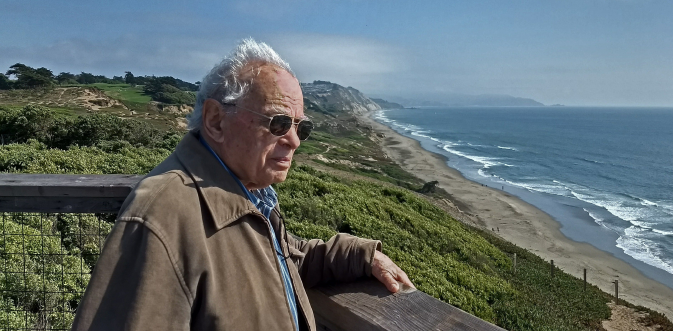
Figure 4. August 2017, San Francisco. Eternity of Pacific. From family archive; courtesy of Arkady and Bella